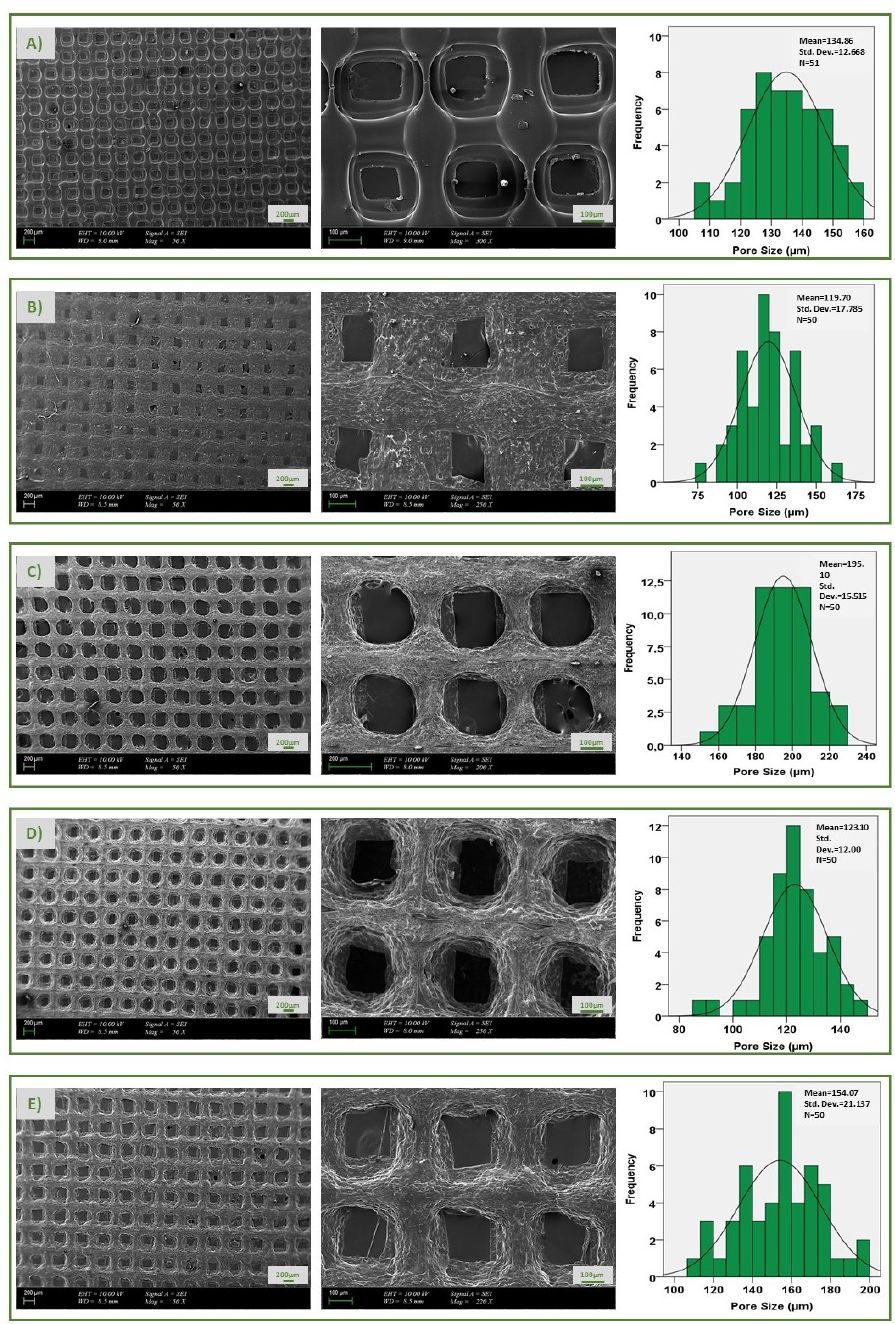
Figure 3. SEM images and pore size histogram of pure 17 PLA ( A ), 17 PLA/3 CS ( B ), 17 PLA/3 CS/0.01 LEV ( C ), 17 PLA/3 CS/0.03 LEV ( D ), 17 PLA/3 CS/0.05 LEV ( E ) scaffolds, respectively.